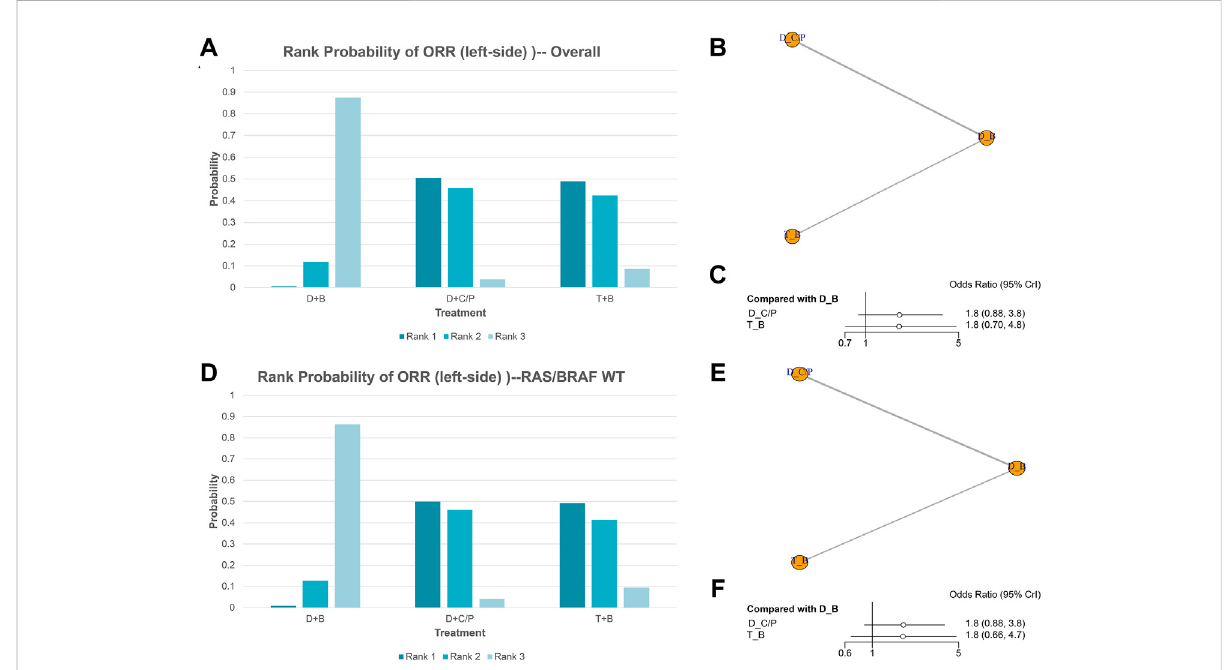
FIGURE 2 Overall response rate (ORR) in overall and the subgroup of RAS/BRAF wild-type patients. Overall: (A) The rank probability of the bene fi ts of the treatments. (B) Network of eligible comparisons for network meta-analysis. (C) Forest plot of comparisons to double-drug regimen plus bevacizumab. RAS/BRAF WT: (D) The rank probability of the bene fi ts of the treatments. (E) Network of eligible comparisons for network meta- analysis. (F) Forest plot of comparisons to double-drug regimen plus bevacizumab. ( N = 1925, B: bevacizumab; C: cetuximab; D: double-drug; P: panitumumab; T: